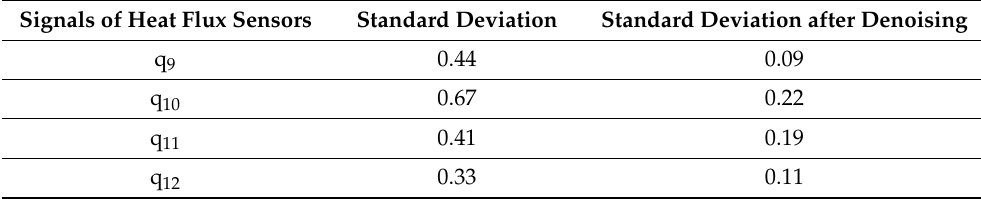
Table 4. Measurement results for both approaches of processing measurement data.